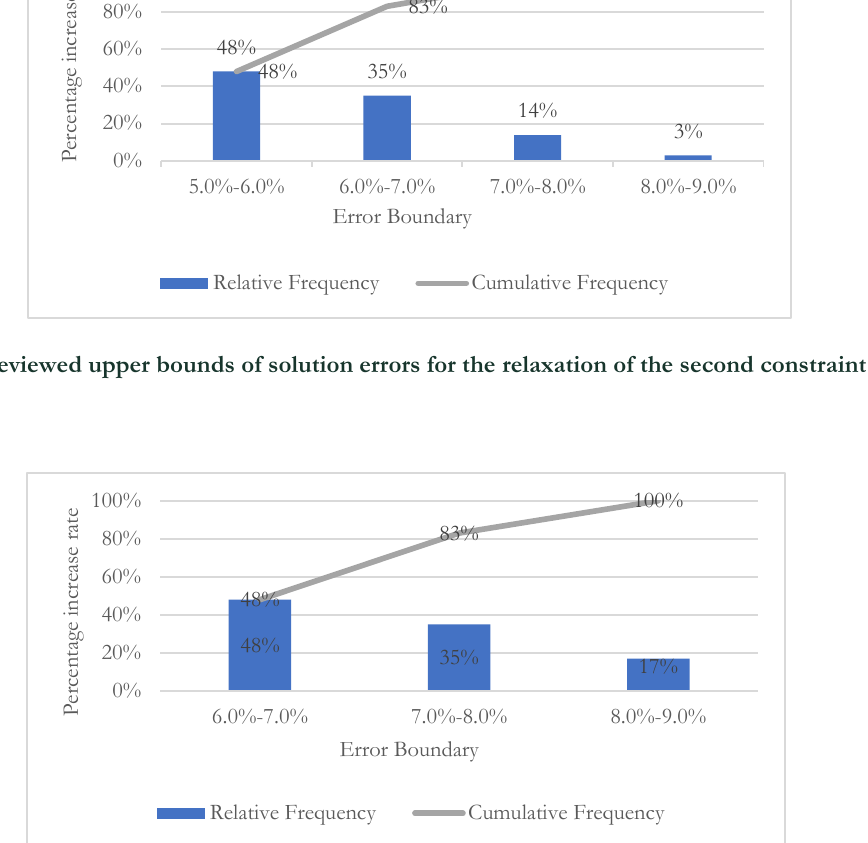
Fig. 5. Reviewed upper bounds of solution errors for the relaxation of the third constraint